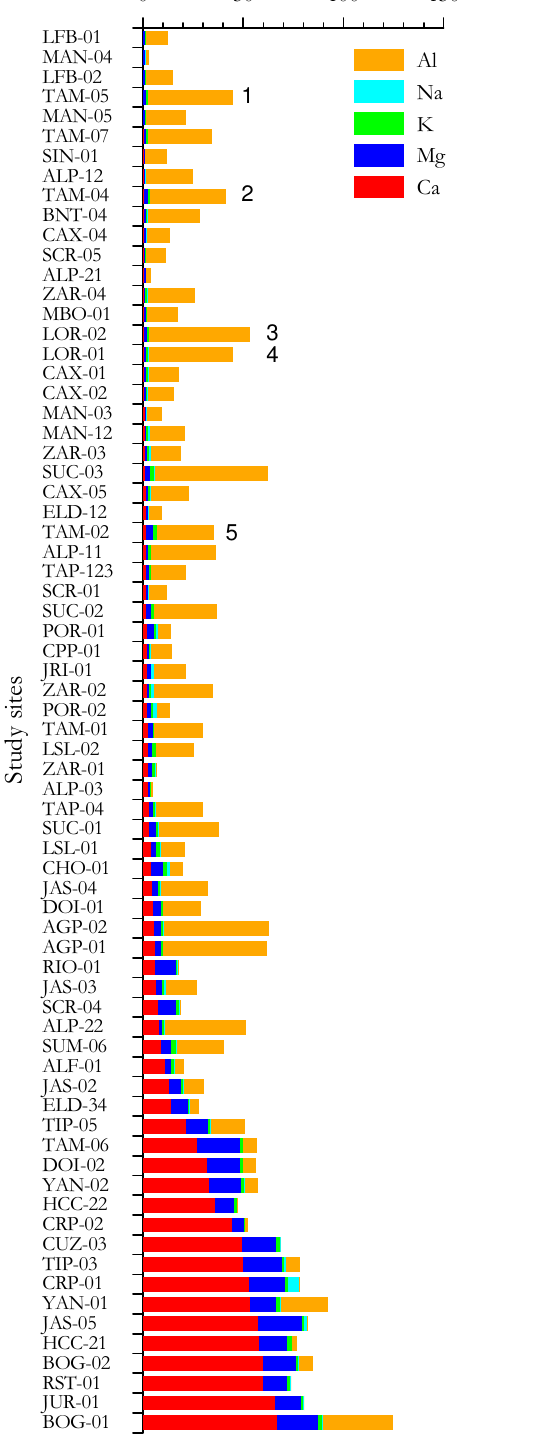
Fig. 4. Exchangeable cations concentrations for each study site, ordered by Ca concentration. See text for numbers.